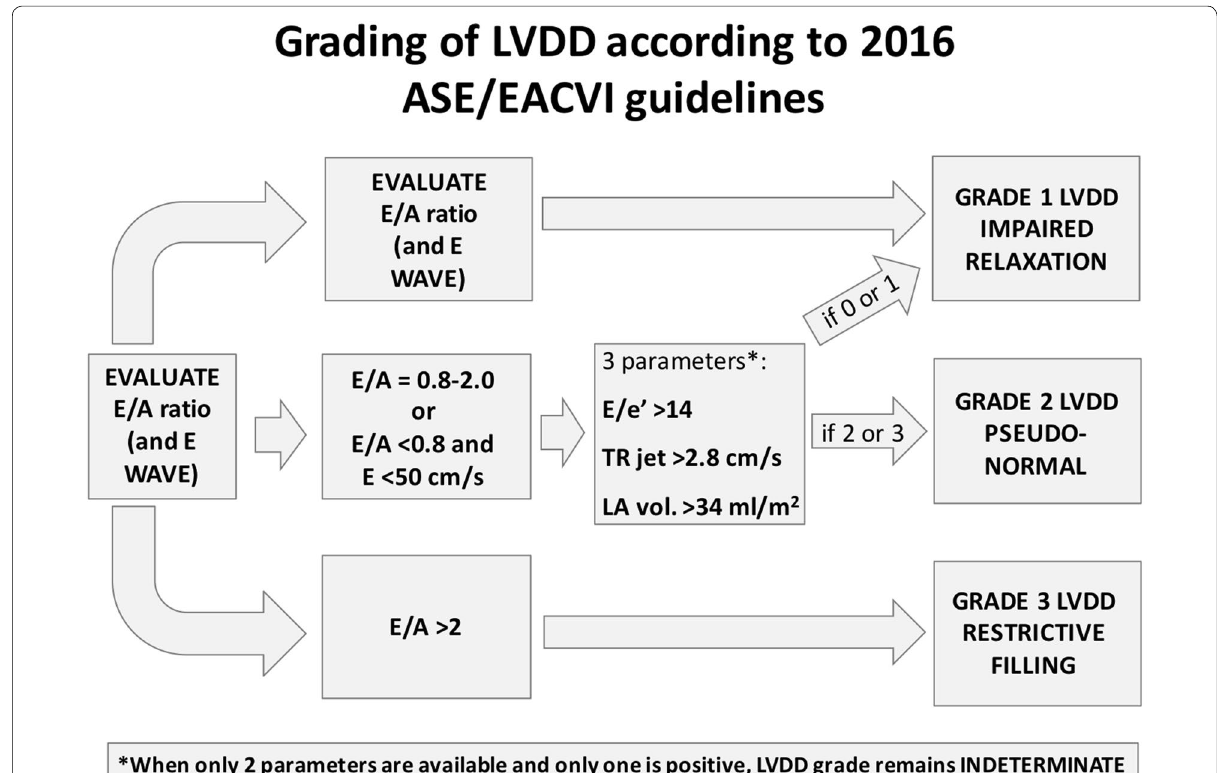
Fig. 2 Algorithm for grading of left ventricular diastolic dysfunction (LVDD) in outpatients according to the 2016 American Society of Echocardiography and European Association of Cardiovascular Imaging (ASE/EACVI)